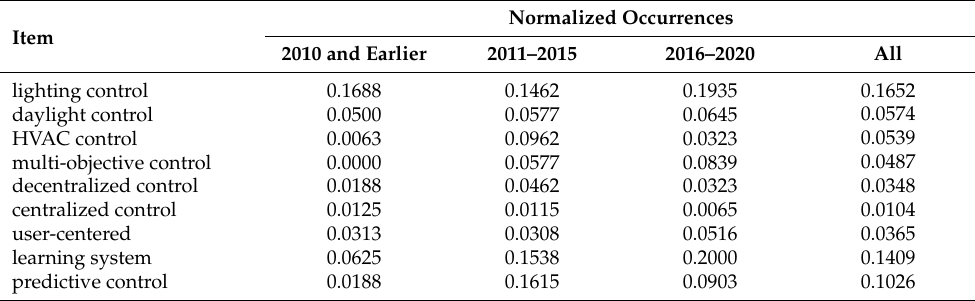
Table 8. Normalized occurrences of building trades and centralized and decentralized system designs as well as the normalized occurrences of the items learning system and predictive control, determined by using